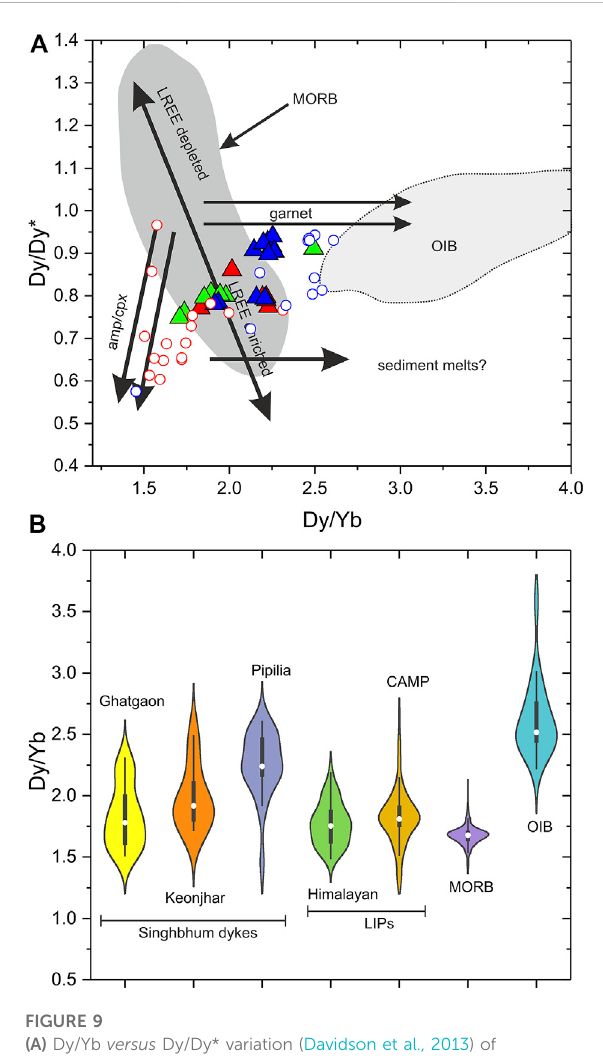
FIGURE 9 (A) Dy/Yb versus Dy/Dy* variation (Davidson et al., 2013) of Ghatgaon, Pipilia and Keonjhar dyke swarms. The REE values in the Dy/ Dy* calculation are normalized to the values reported in McDonough and Sun (1995). (B) Violin plot with box plots inside illustrating the variation of Dy/Yb ratios of Ghatgaon, Keonjhar and Pipilia dyke swarms. Large igneous provinces are sourced from a subduction-modi fi ed mantle, which includes the Himalayan magmatic province and CAMP (Data source: Manu Prasanth et al., 2022). The ocean island basalt (OIB) data from Hawaii (from The GEOROC Database: https://georoc.eu/ georoc/new-start.asp), and Global MORB variations, which include N-MORB and E-MORB data (Arevalo Jr and McDonough, 2010) are also shown for comparison. White circles inside the box represent mean whereas the Pipilia swarm exhibit Dy/Yb =2.2. The Dy/Yb variations are slightly higher than MORB values (~1.6) and considerably lower than the OIB values (~2.5) (Figure 9B). The Himalayan magmatic province and CAMP proposed to be derived from a subduction- modi fi ed mantle source (Tegner et al., 2019; Manu Prasanth et al., 2022) also show overlap with the Dy/Yb variations of the Ghatgaon, Keonjhar and Pipilia swarms (Figure 10). The Dy/Dy* vs. Dy/Yb (Davidson et al., 2013), relations exhibit LREE enriched fi eld with garnet control on some of the Keonjhar and Pipilia swarms. Most of the Ghatgaon swarm samples exhibit clinopyroxene fractionation (Figure 9A). Some samples from Dhenkikote area of Ghatgaon dyke